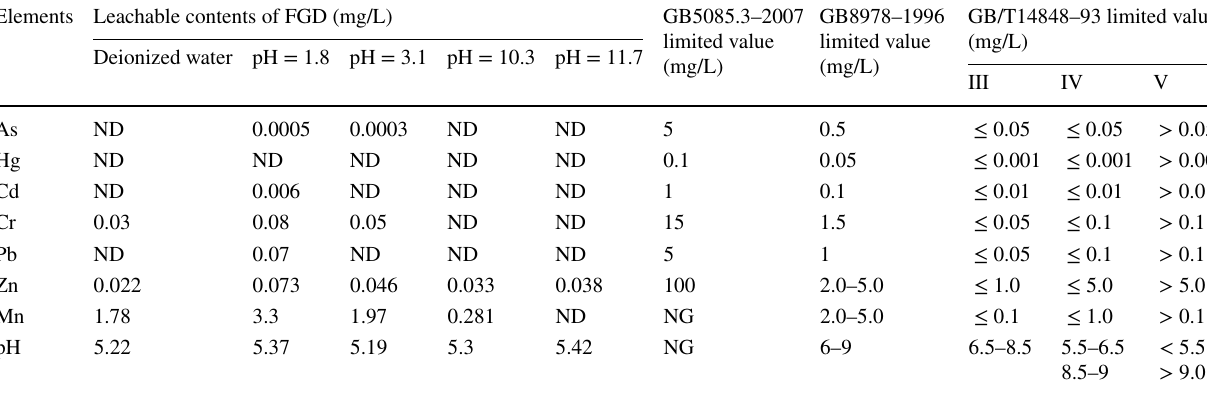
Table 6 Comparison between leachable contents of the elements in FGD gypsum and national environmental quality standard limits for hazard- ous pollutants